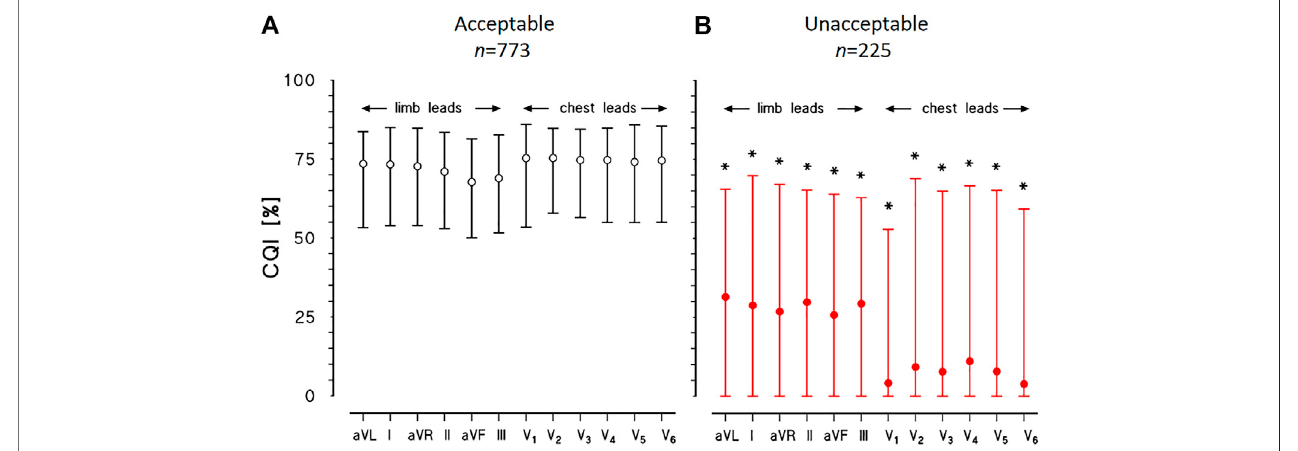
FIGURE6| Physionet/Computing in Cardiology Challenge 2011datasets. CQI median and interquartilerange foreach of12leadsofECG recordings classi fi edas “ acceptable ” (A) or “ unacceptable ” (B) : for each lead, the * indicates statistically signi fi cant difference between groups at p < 0.01.